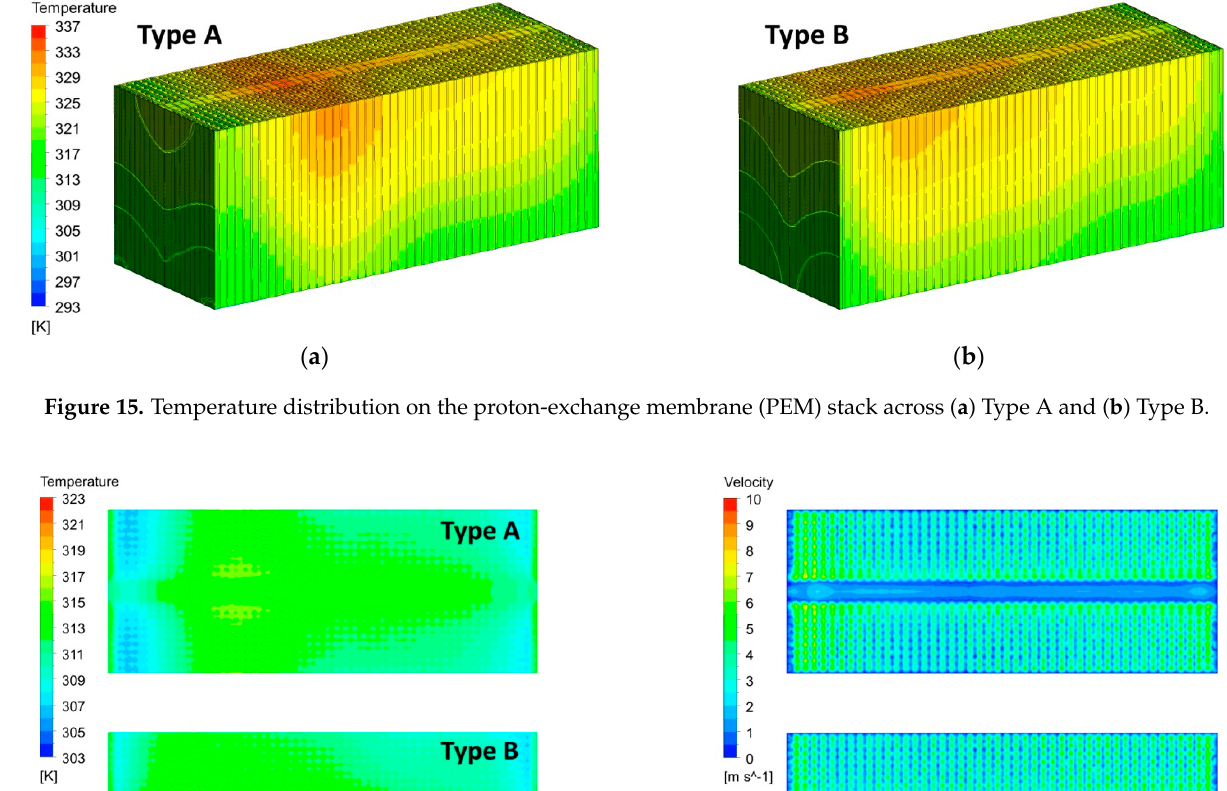
Table 4. Output values from analysis of CFD model.